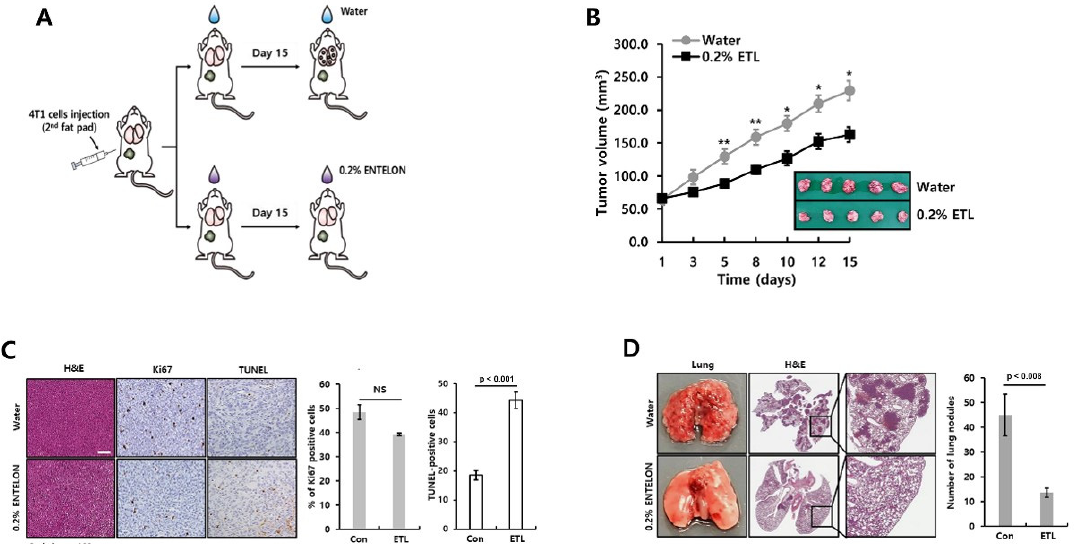
Figure 7. ETL prevents the tumor growth and metastatic capacity of TNBC cells. ( A ) schematic model of the experimental procedure. ( B ) the size of the tumors in each group (n = 5) was measured and analyzed for 15 days. ( C ) the results, confirmed by immunohistochemistry, were scored. Quantitative data were obtained through the calculation of four fields to analyze the experimental results of Ki-67 and TUNEL-positive cells. ( D ) after 15 days, the lung tissues were dissected and analyzed for metastatic events. The number of metastatic nodules was counted in the lung tissue. The values are presented as the mean ± standard error of independent experiments. * p < 0.05, ** p < 0.01 vs. ( − ) control. Scale bar = 100 µ